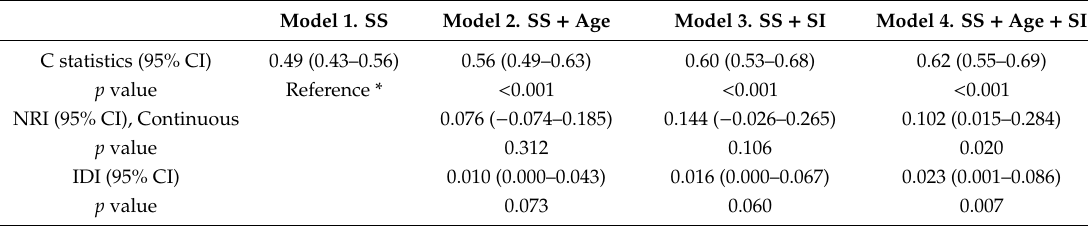
Table 3. Predictive Performance of Models for